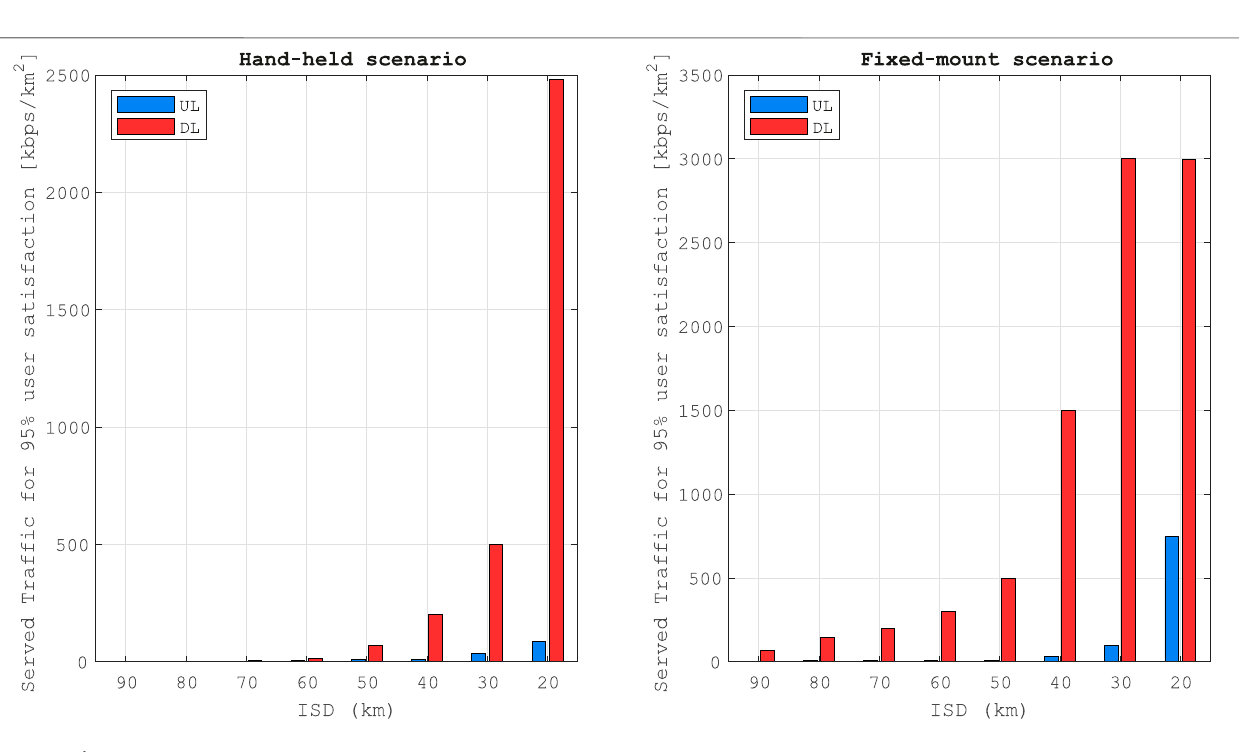
FIGURE 6 | Capacity (served traf fi c at 95% service coverage) for different STN scenarios.